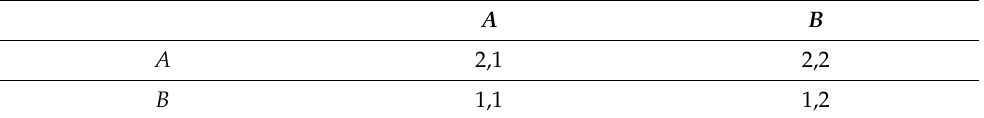
Table 2. Agents’ output with a single Nash equilibrium.